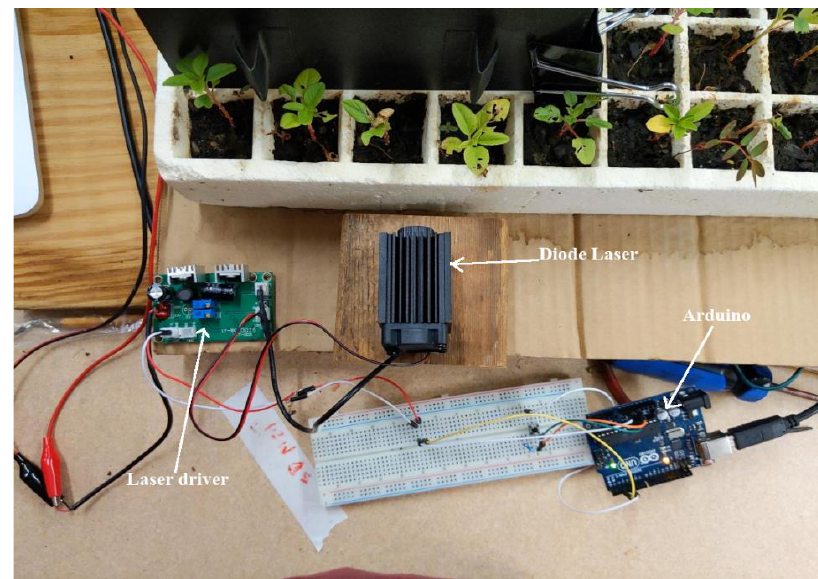
Figure 5. Weeds in the pots being treated by a diode laser.